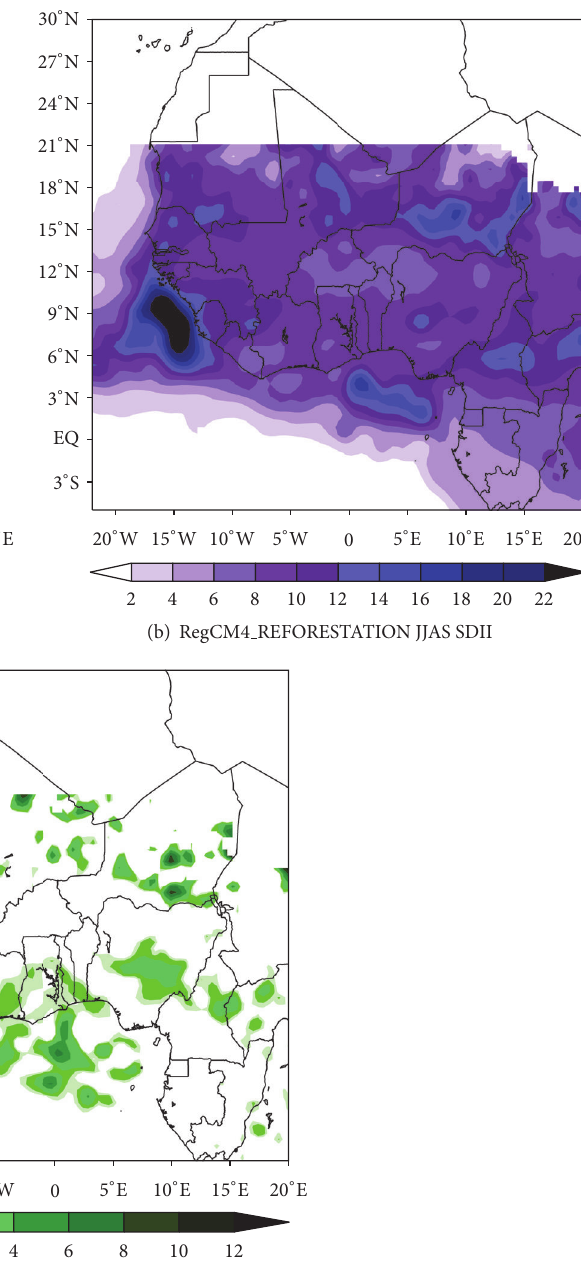
∘ ∘ 15 N and 20 N may be linked to the strong increase of the sensible heat flux over the same region and during the same period (figure not